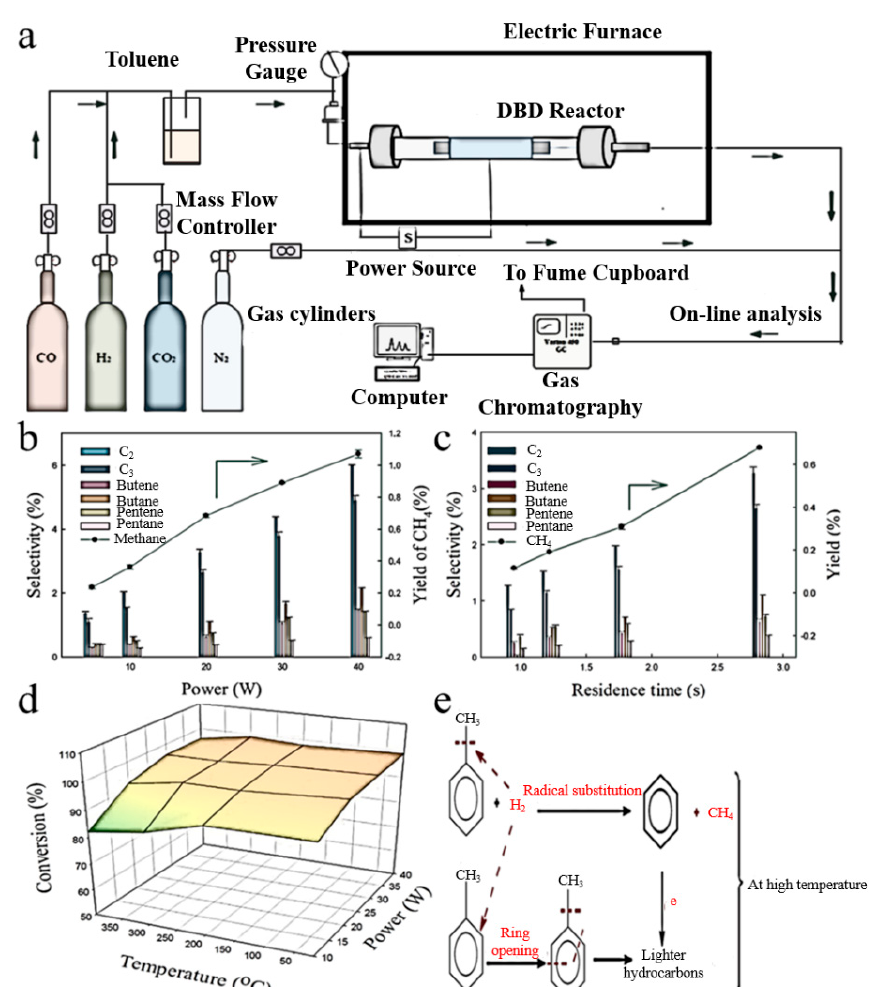
Figure 11. ( a ) experimental setup; ( b ) influence of plasma power on individual lower hydrocarbons; ( c ) effect of residence time on individual lower hydrocarbons; ( d ) influence of temperature on the toluene conversion; ( e ) reaction mechanism at elevated temperature. Reproduced with permission from [130]; Copyright Elsevier, 2019.